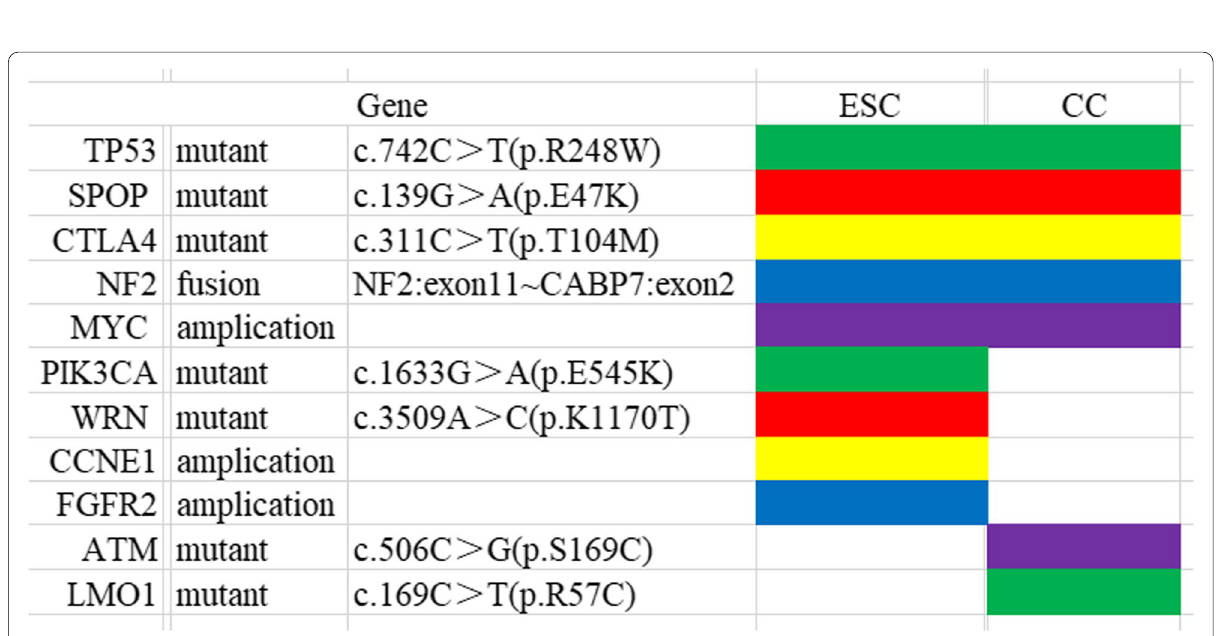
Fig. 4 Common and difference of different gene changes in ESC with CC